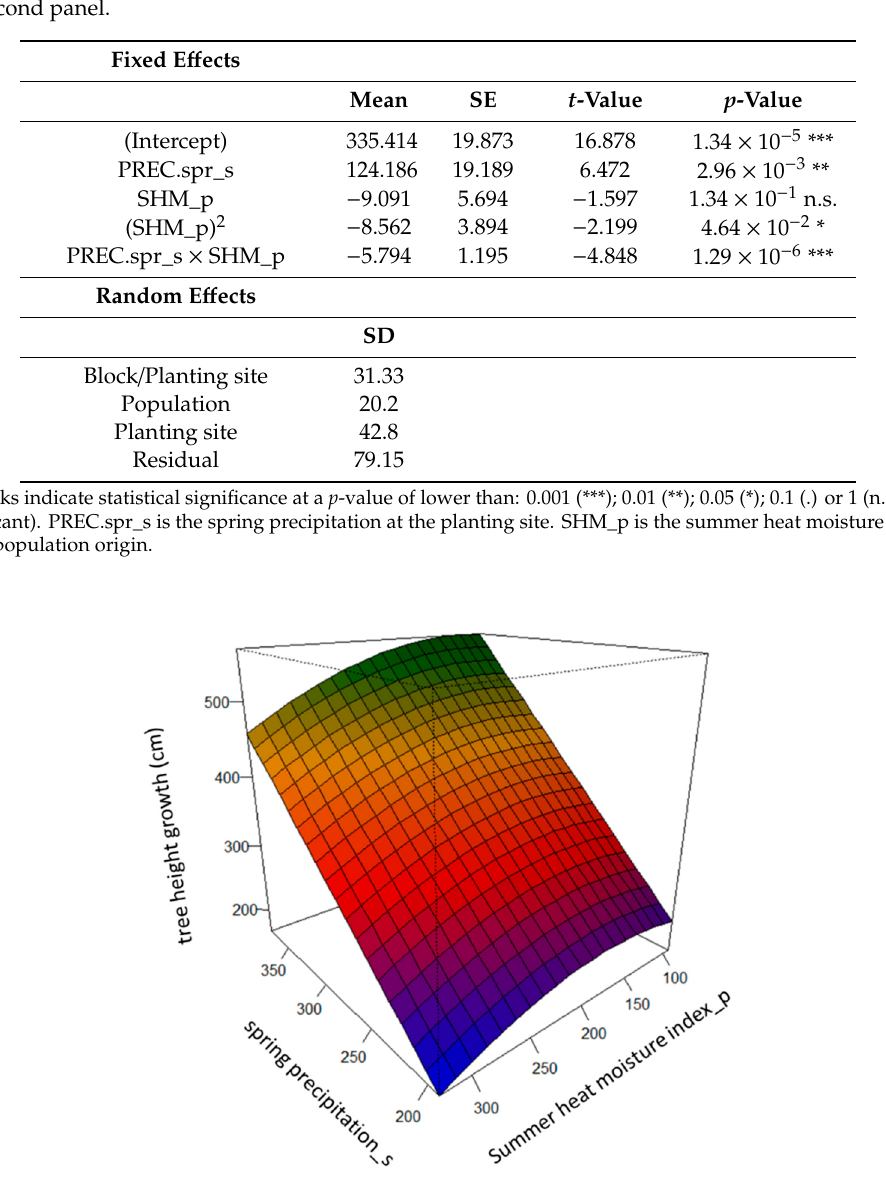
Figure 1. Predicted tree height growth (cm), based on the best supported linear mixed-effect model across the gradients of spring precipitation of the planting sites, PREC.spr_s, and of the summer heat moisture index of the populations’ origin, SHM_p.